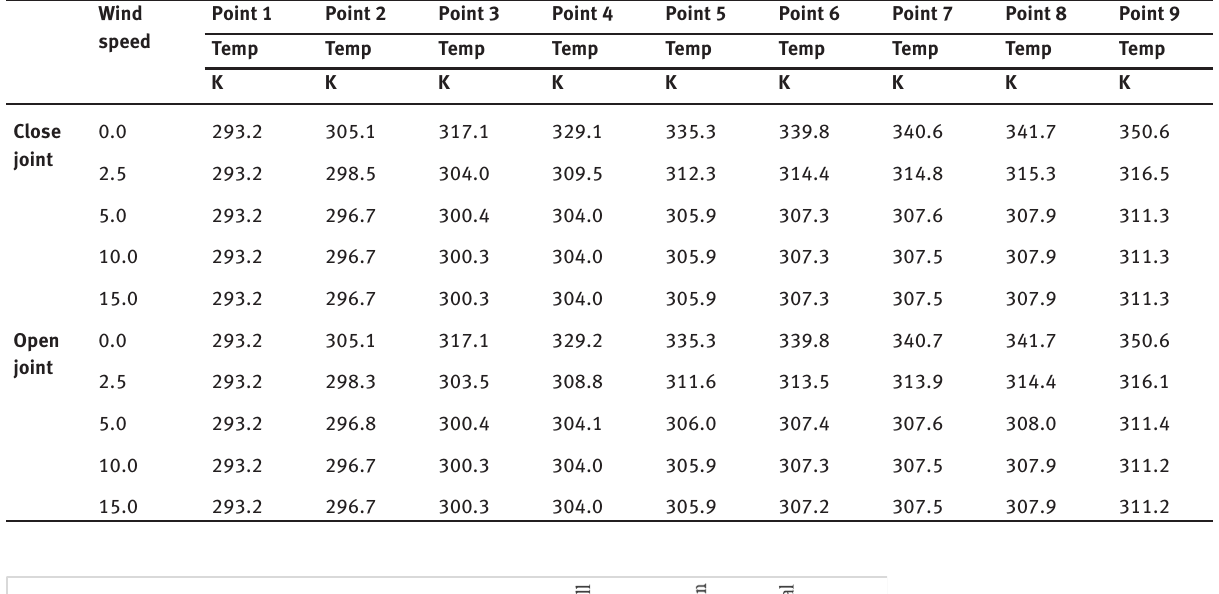
Table 2: Compilation of temperatures for measurement points inside the room and within the wall. Wind Point 1 speed